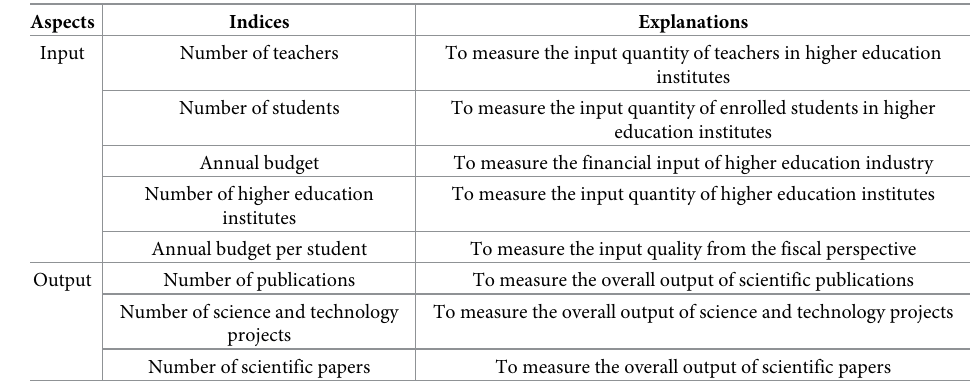
Table 1. Coordination assessment system for higher education.